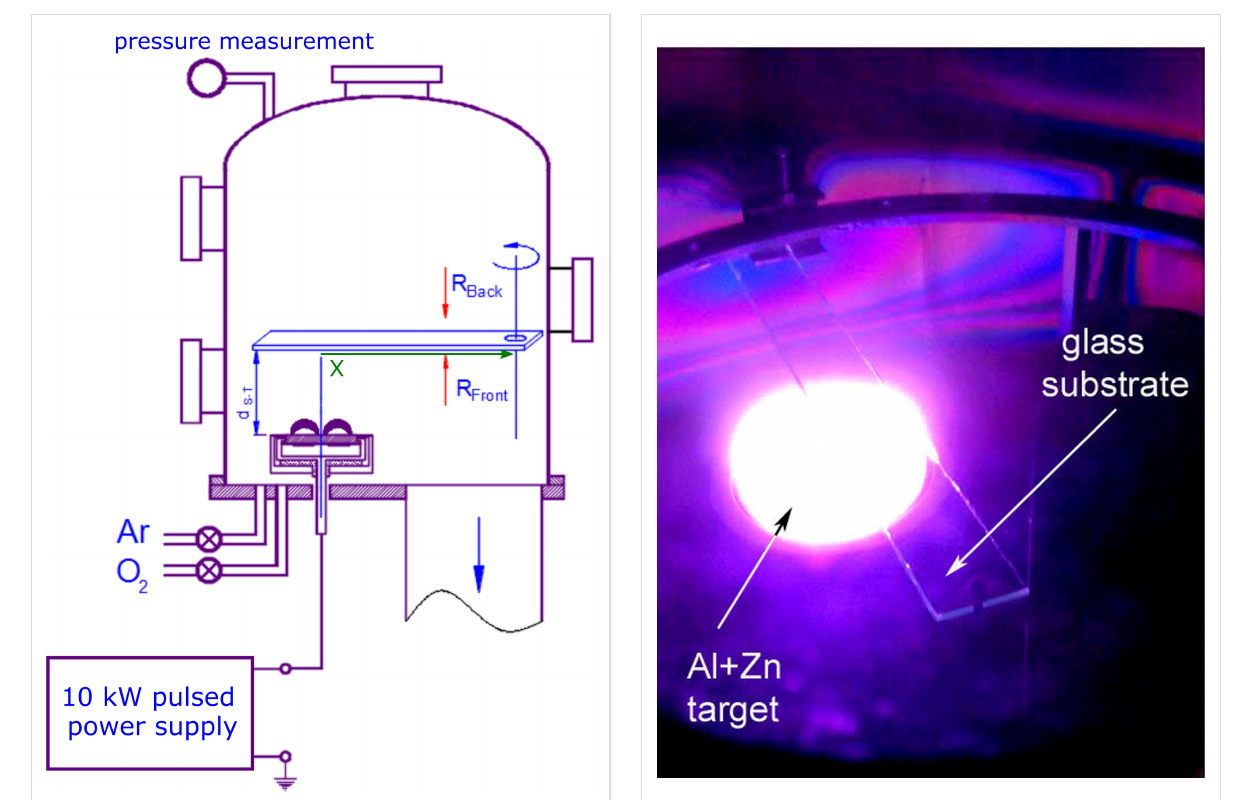
pressure during reactive sputtering processes was established at about p Ar+O2 = 3 × 10 − 3 mbar. The power supplying the target (the discharge power) was equal to 400 W. The power supply is the medium frequency pulsed power supply, inducing a pulsed magnetron discharge. The output current pulses are sinusoidal with a duration of 10 µs and a stabilized amplitude of 16 A.